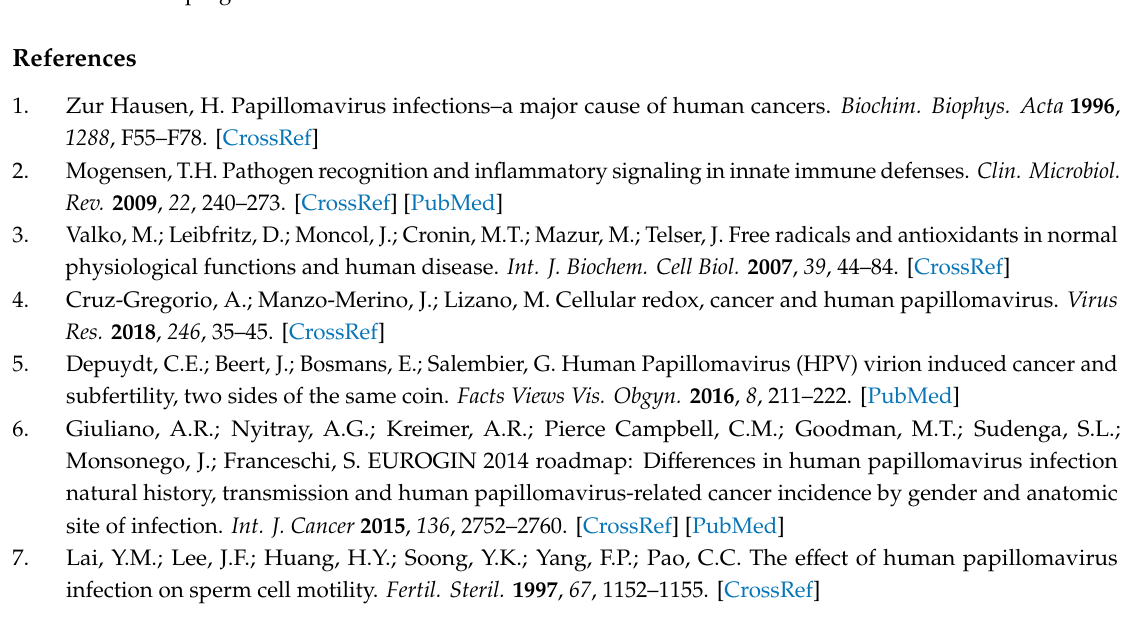
Figure S1: Immunofluorescence confocal microscopical images of AQP3, AQP7, and HPV in human sperm, Figure S2: Immunofluorescence negative control, Figure S3: Negative control of co-immunoprecipitation of AQP8 and HPV L1 proteins in human sperm